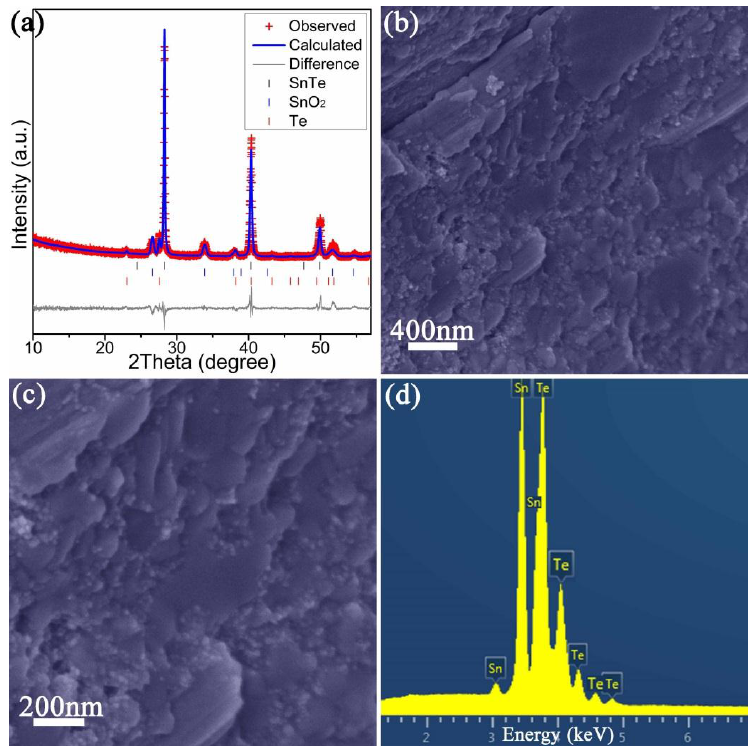
Figure 4. Characterisation of the SnTe pellet: ( a ) Profile plot from Rietveld refinement against PXD data; ( b , c ) SEM images; ( d ) EDS spectrum.